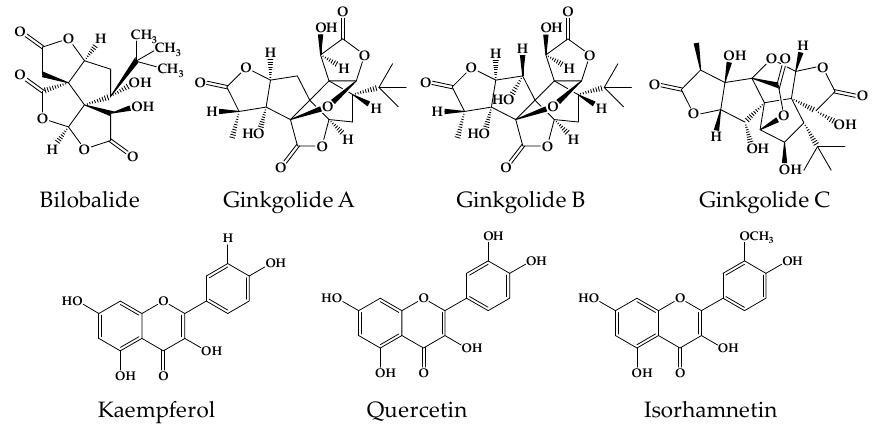
Figure 1. The chemical structures of the ginkgo terpene lactones and flavonols investigated in this study.